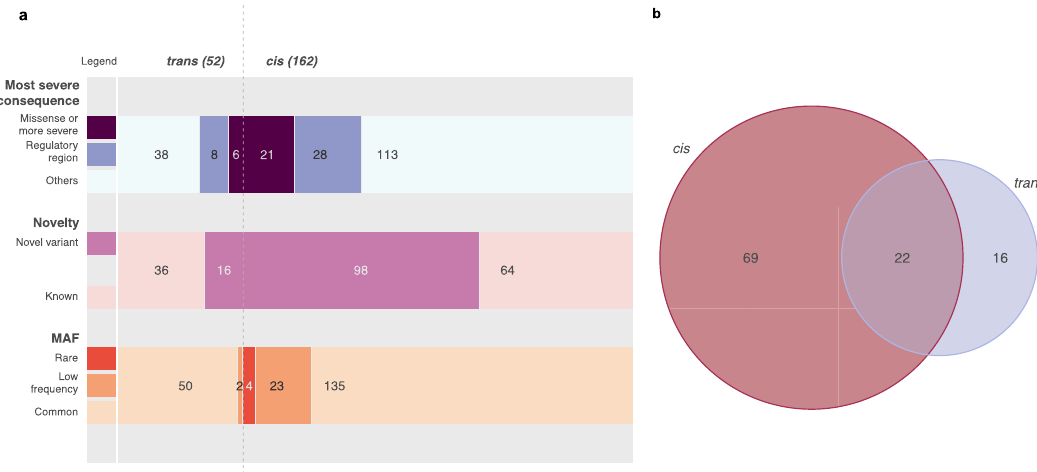
Fig. 2 Overall genetic architecture of 107 serum proteins of neurological relevance. a A total of 214 independent variants were detected. Cis -acting variants were de fi ned as variants lying within 1 Mb upstream and downstream of the gene encoding the target protein, while trans -acting variants are variants that lie outside of this region. Most severe consequence was determined by Ensembl ’ s variant effect predictor (VEP). Effects more than missense included ‘ stop_gained ’ , ‘ frameshift_variant ’ , and ‘ splice_acceptor_variant ’ in our dataset; ‘ Regulatory region ’ variants include ‘ [3/5]_primeUTR_variant ’ , ‘ TF_binding_site_variant ’ , ‘ splice_region_variant ’ , and ‘ regulatory_region_variant ’ ; while ’ Others ’ comprises mostly intergenic and intronic variants. Novelty was assessed by cross-referencing published summary statistics from other pQTL studies (Supplementary Data 2). Known pleiotropic loci were not considered novel. Rare, low-frequency and common variants were de fi ned as variants with minor allele frequency (MAF) < 1%, MAF 1 – 5%, and MAF > 5%, respectively. b Number of proteins for which we detected only cis -pQTLs, trans -pQTLs, or